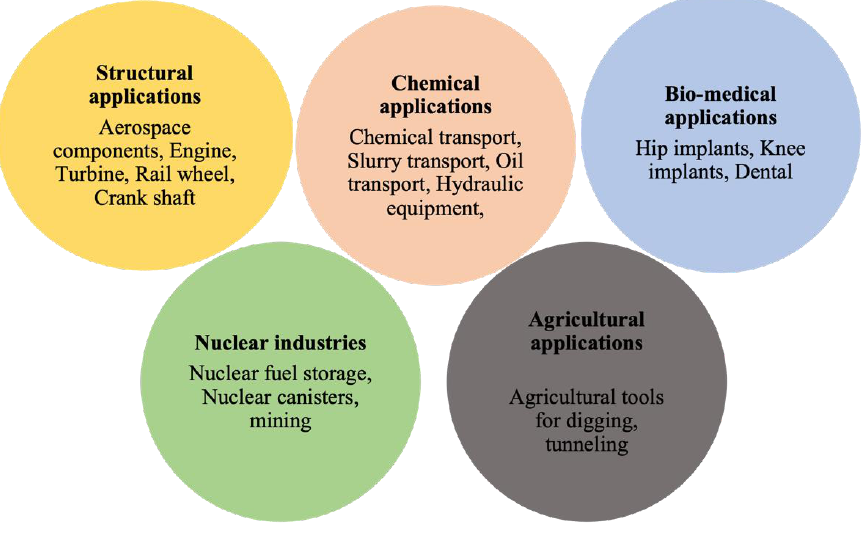
Figure 17. Applications of LC process.